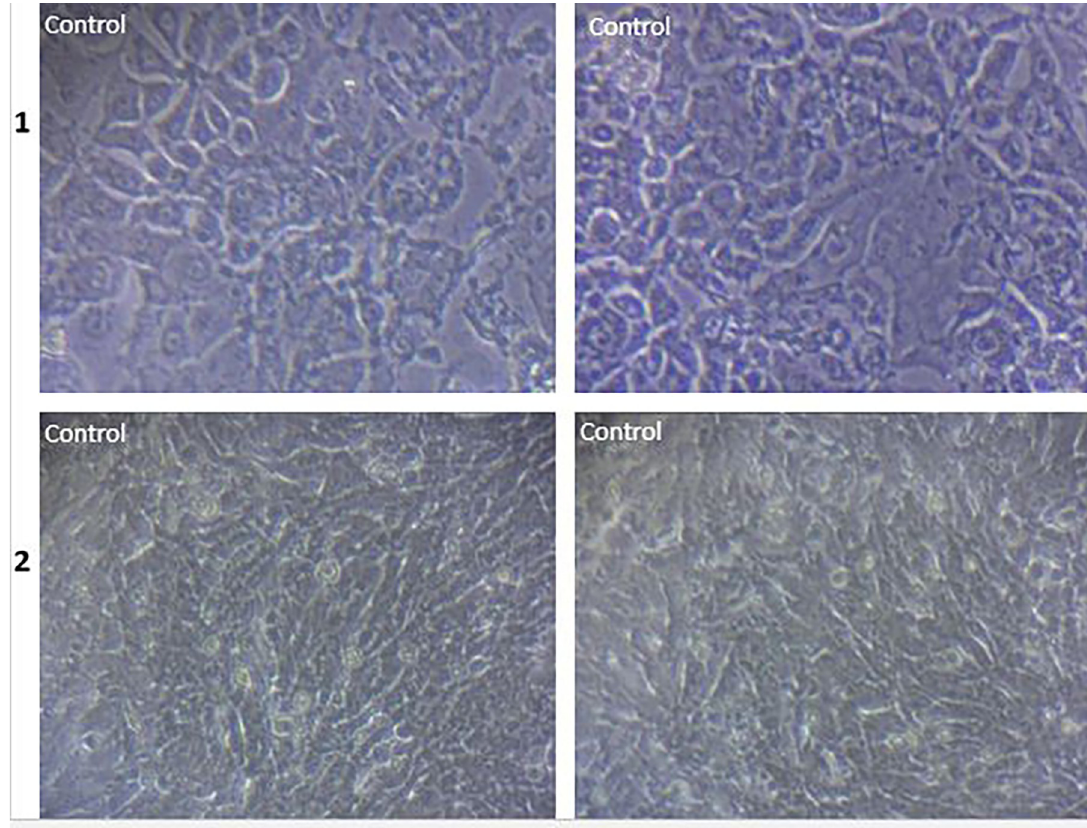
Fig 4. Morphology of the control cell line of MCF7 (row 1) and HUVEC cell lines (row